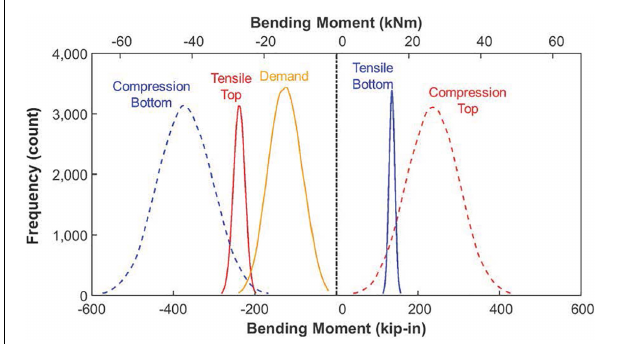
FIGURE 6 | Results from MCS of sleeper center bending moments for HAL freight.